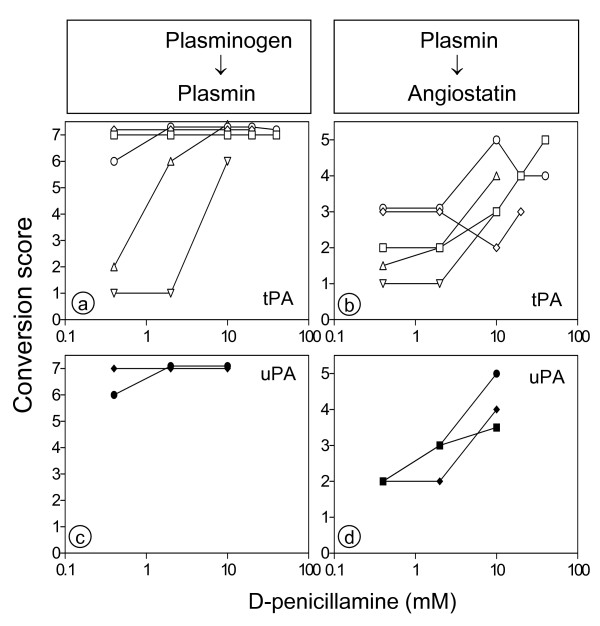
Summary of in vitro angiostatin generation by plasminogen activators and D-penicillamine. Murine serum was incubated for 0, 2, 4.5 or 20 hours with D-penicillamine and tPA (a and b) or uPA (c and d). Conversion of plasminogen to plasmin (a and c) and plasmin to angiostatin (b and d) were scored separately on a semi-quantitative scale. Note concentration dependent conversion of plasminogen to plasmin (a), and conversion of plasmin to angiostatin (b) with increasing concentrations of tPA and D-penicillamine (b). Surprisingly, uPA was very efficient in plasmin generation (c), while with increasing uPA concentrations a reciprocal effect on angiostatin formation was observed (d). tPA concentrations (μg/ml): : 0.08;  0.4; : 2;  : 4;  : 20 and 100 uPA concentrations (units/ml):  : 0.004;  : 0.02;  : 0.1.